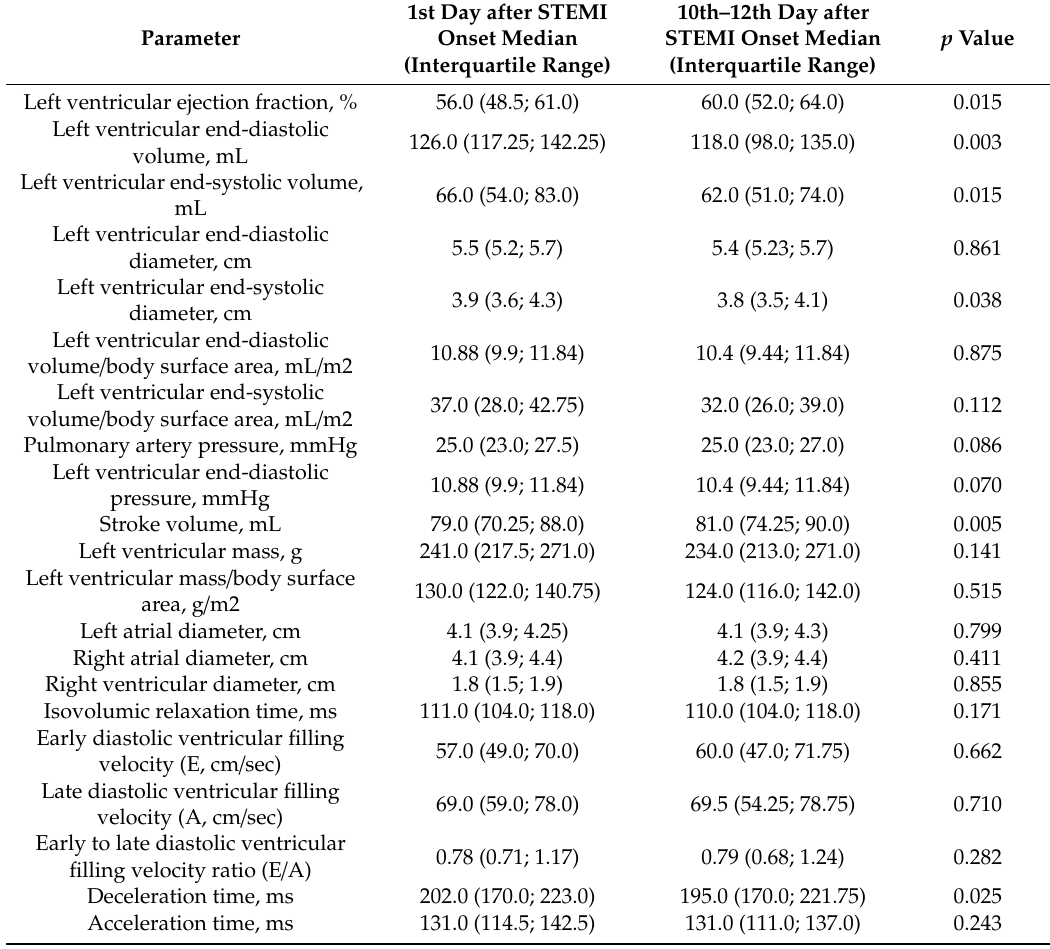
Table 4. Echocardiographic parameters in patients diagnosed with ST-segment elevation myocardial infarction with preserved ejection fraction (HFpEF, n = 100) at the time of admission and on 10th–12th day of hospital